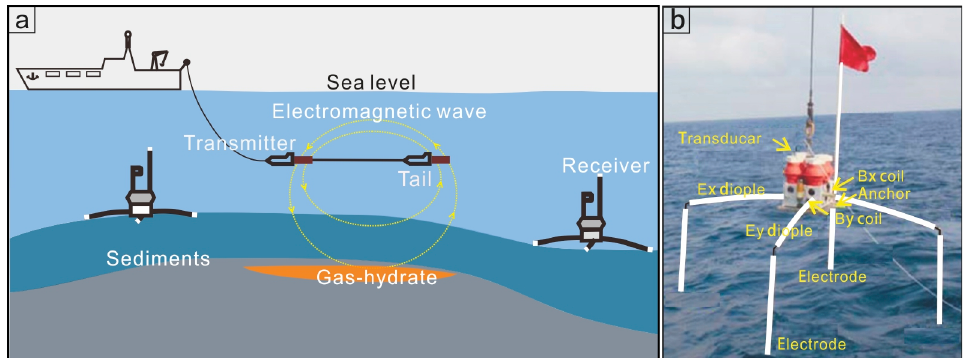
Figure 4. ( a ) Schematic diagram of the electromagnetic technological principles and detection devices for the MCSEM method; ( b ) Electromagnetic receiver (modi fi ed from Reference [50]).